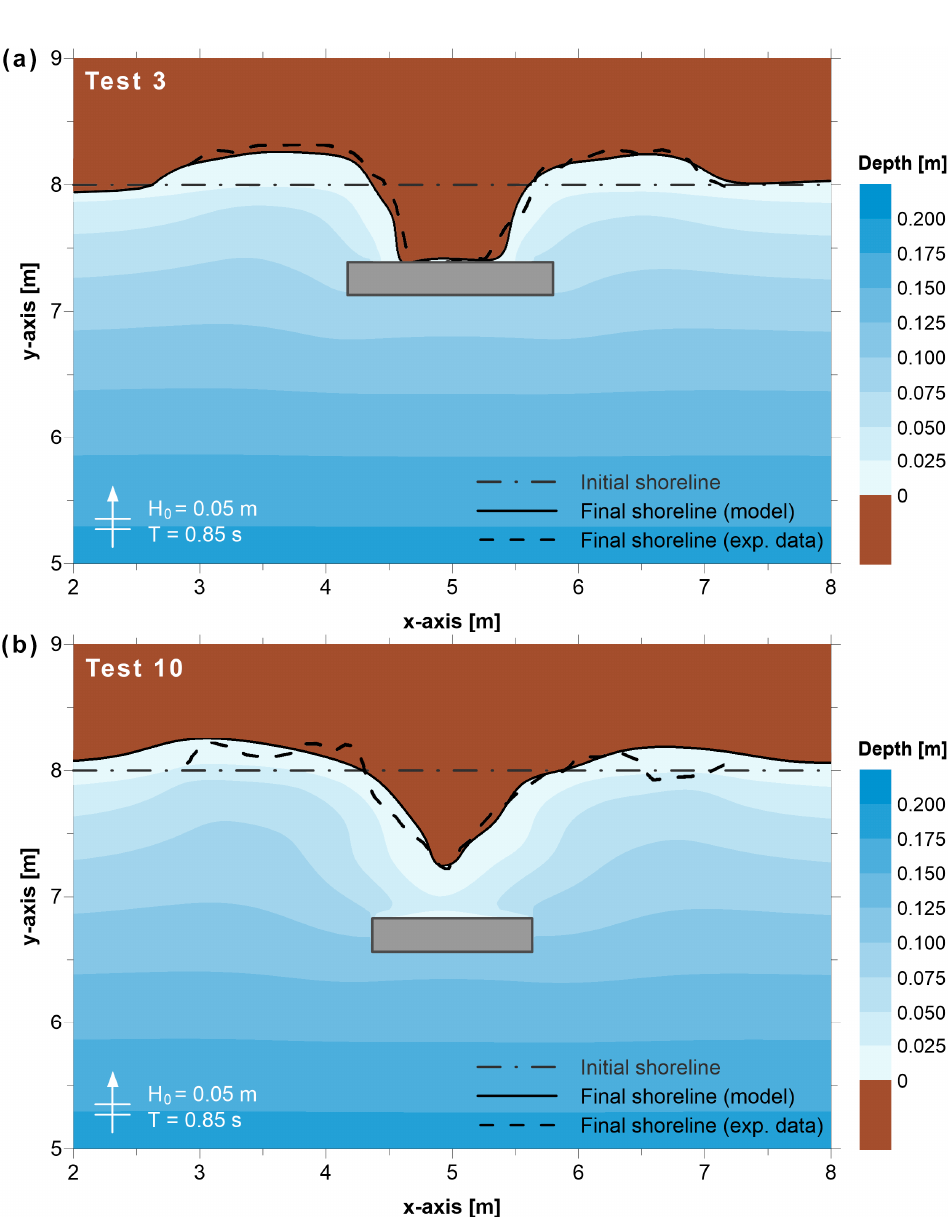
Figure 3. Comparison between the computed and measured shorelines evolution (contours represent the final computed bathymetry) for: ( a ) Test 3 and ( b ) Test 10 of Ming and Chiew [21].